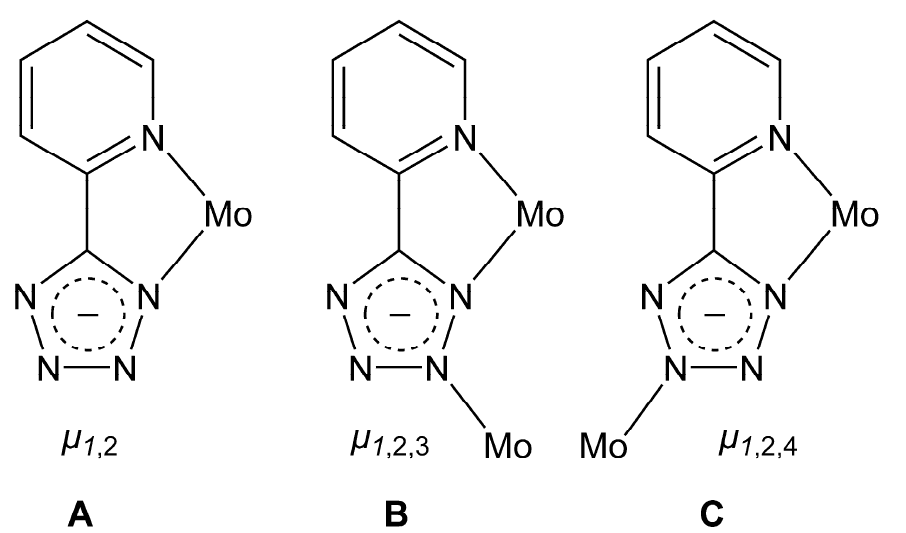
Figure 7. ( A ) The bidentate coordination mode present in complex 1 and ( B , C ) the dual chelating/bridging modes that may be present in the structure of the hybrid 2